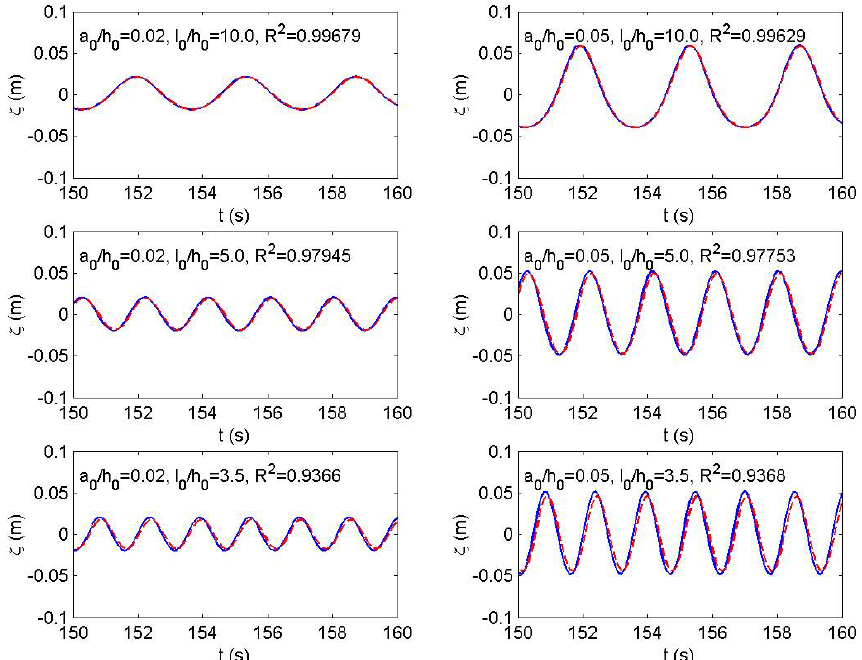
Fig. 5. Time series of water surface elevations in the 1-D tests with periodic waves, computed in outer grid (—) and inner grid (-